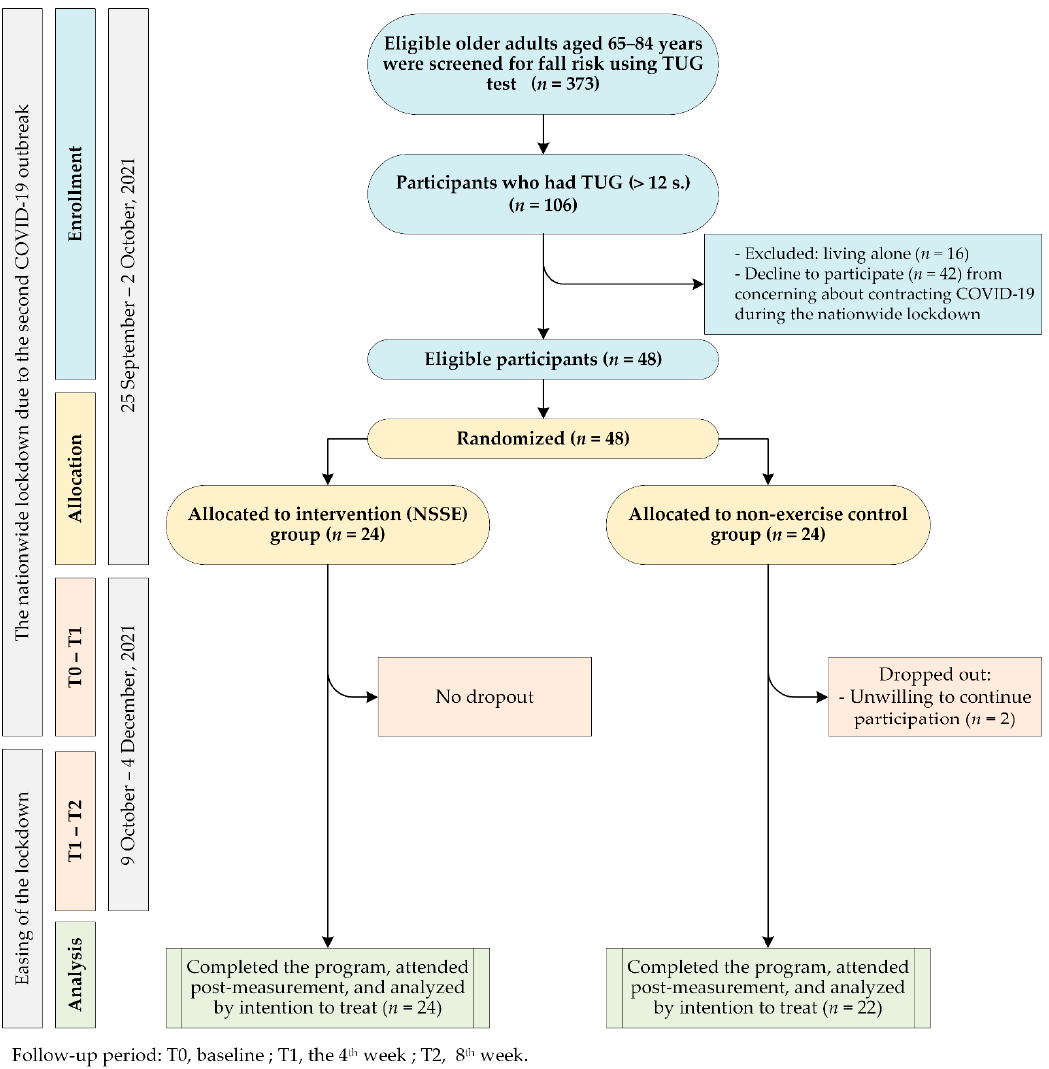
Figure 3. The flow diagram of the participants through each stage of the study. TUG, Timed Up and Go.